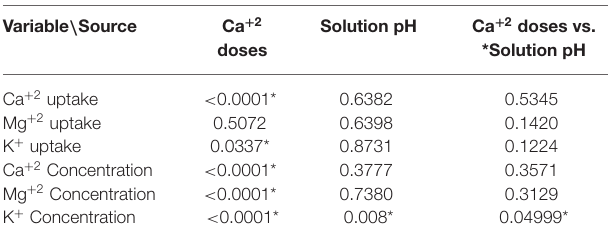
TABLE 4 | Pr > F -values from the statistical output (Anova, 5%) for Calcium (Ca + 2 ) and solution pH on cation uptake rates.